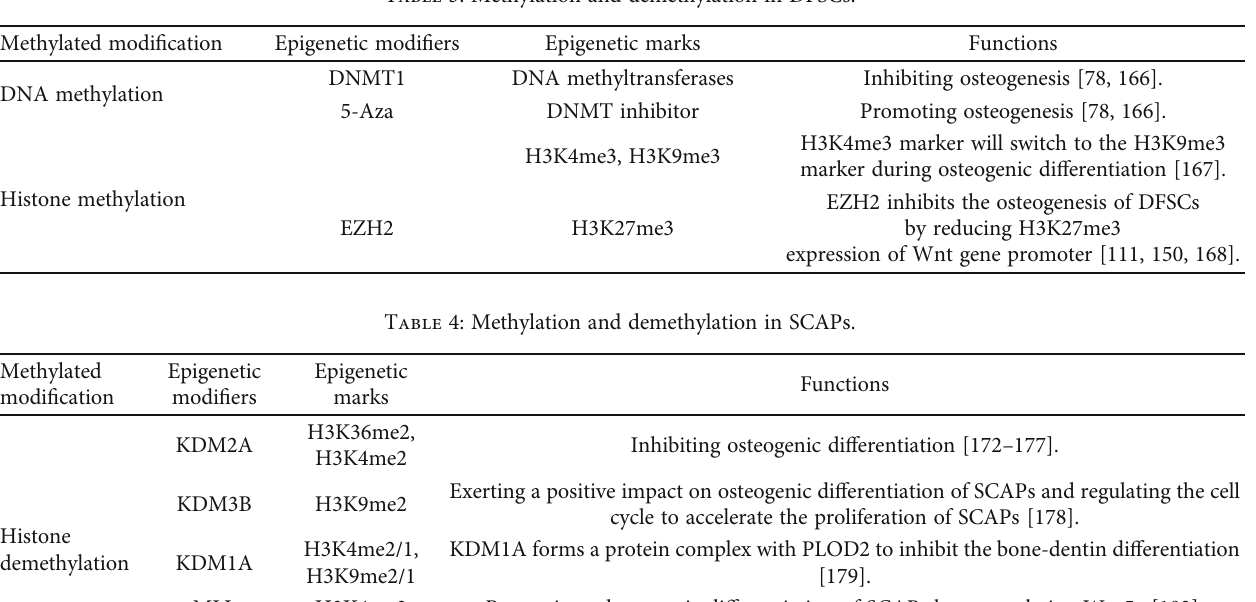
Table 3: Methylation and demethylation in DFSCs.